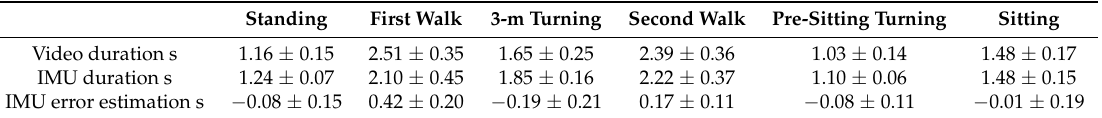
Table 4. Average time duration and error from the IMU activities segmentation algorithm compared to the video analysis of the young subjects.